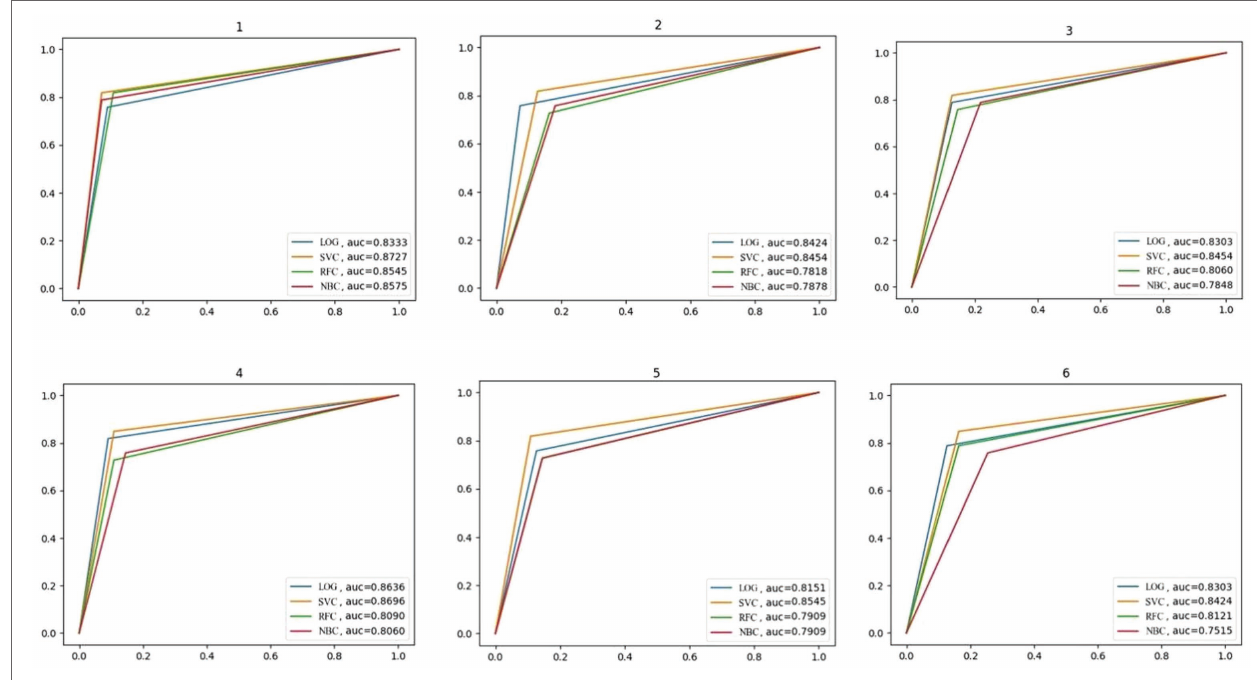
FIGURE 4 | The ROC